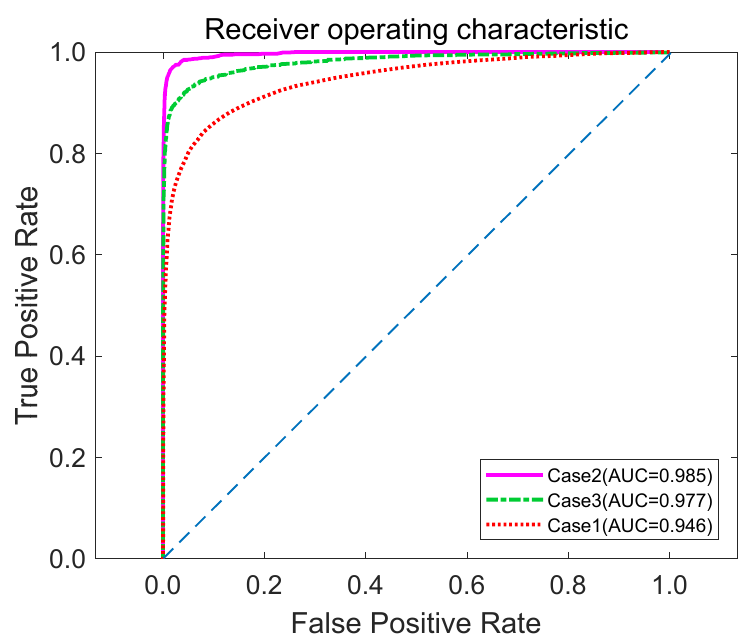
Figure 10. ROC curves of our method under different input conditions.